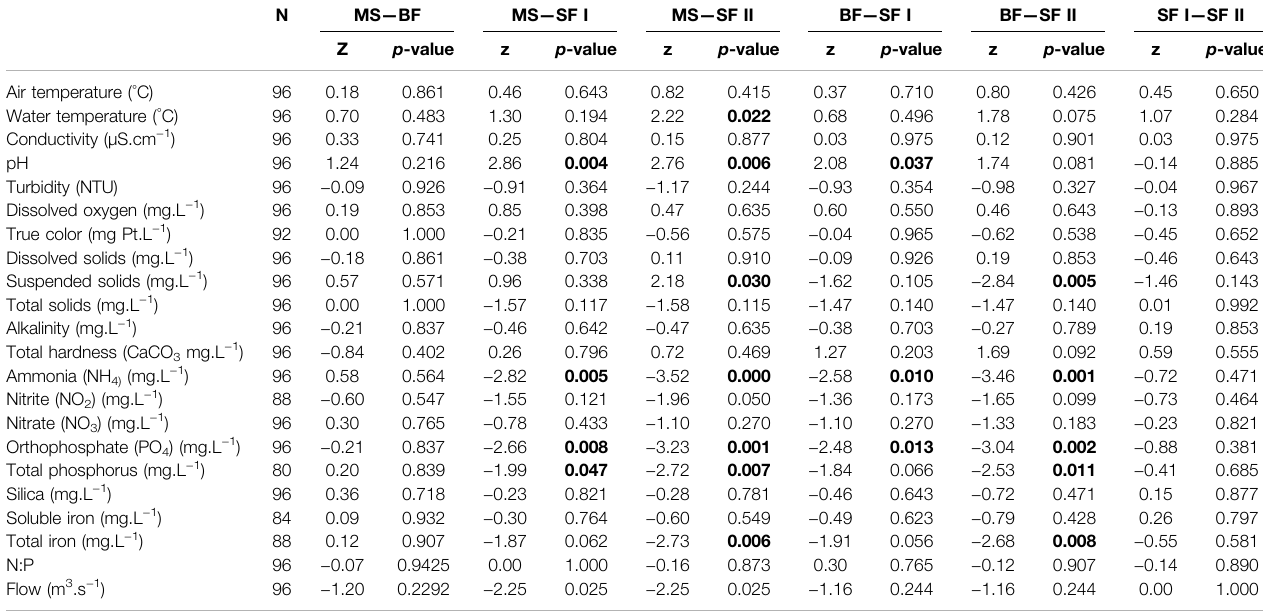
TABLE 1 | Difference of physical and chemical characteristics of Monte Serrat (MS), Bonfante (BF) and Santa Fé (SF I and SF II) reservoirs. Wilcoxon signed-rank test was used for variables with non-normal distribution. Signi fi cant values ( p < 0.05) are highlighted in bold. N MS — BF MS — SF I MS — SF II BF — SF